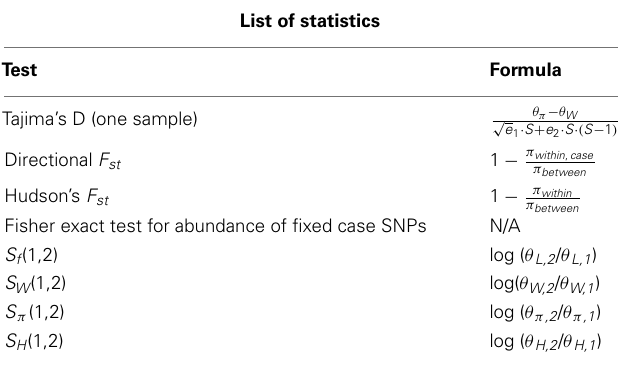
Table 1 | List of statistics